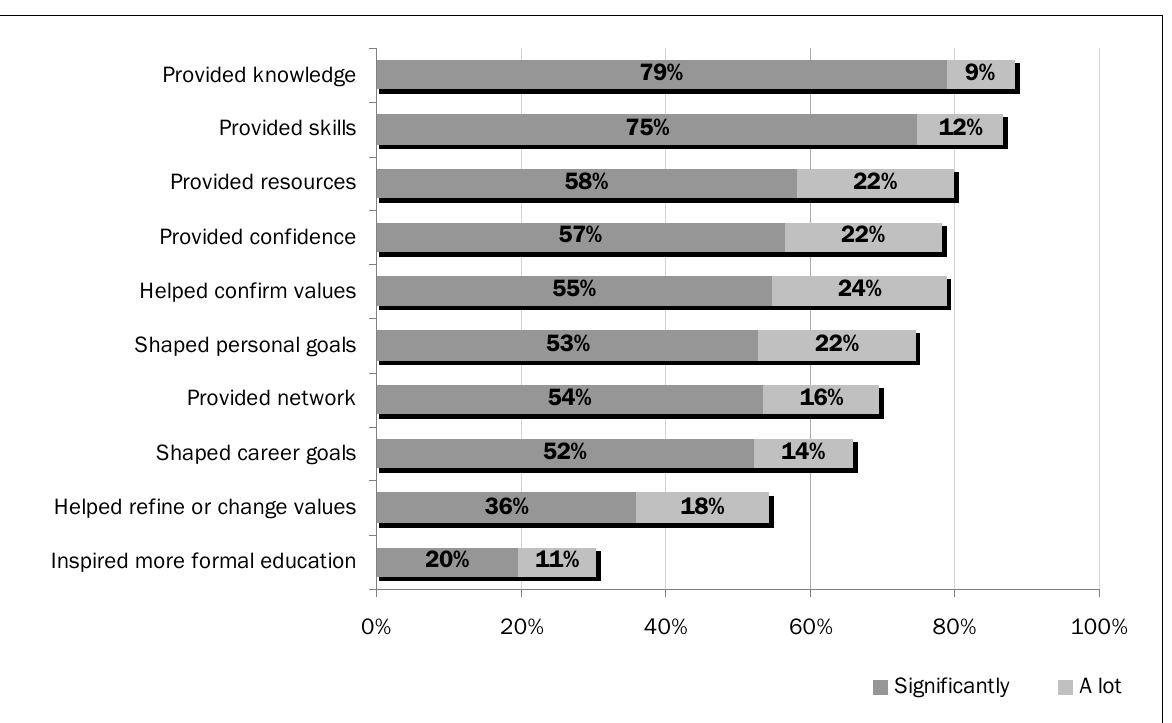
Figure 2: Percent of respondents who said the following learning outcomes contributed “significantly” or “a lot” to their work, volunteer or personal activities after graduating